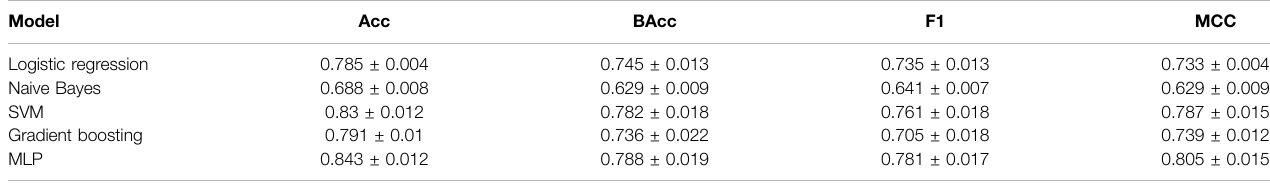
TABLE 4 | Results for the classi fi cation of taxonomic types on basic spectral features. For each metric, the fi rst column is the average over the results 10 runs of the cross- validation, while the second column is the standard deviation of these results. Model